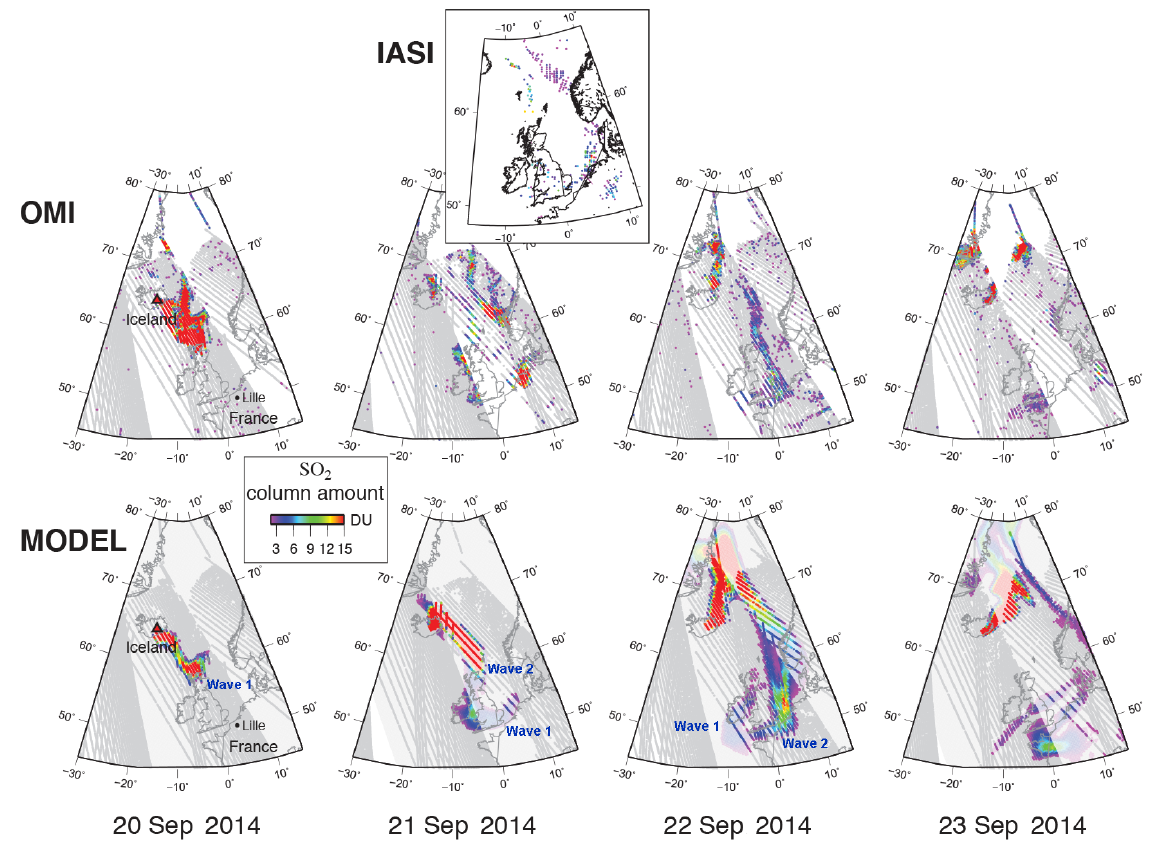
Figure 6. Dispersion of SO 2 from Bárðarbunga eruption toward Europe in late September 2014 (top) observed from satellite imagery (time series of OMI PBL products and IASI data in inset for 21 September) and (bottom) modelled using CHIMERE chemistry-transport model. Grey points indicate OMI column amounts < 2DU. White zones show areas where data are not available. To facilitate the comparison between model and observations, the model is displayed transparently over zones where OMI data are not